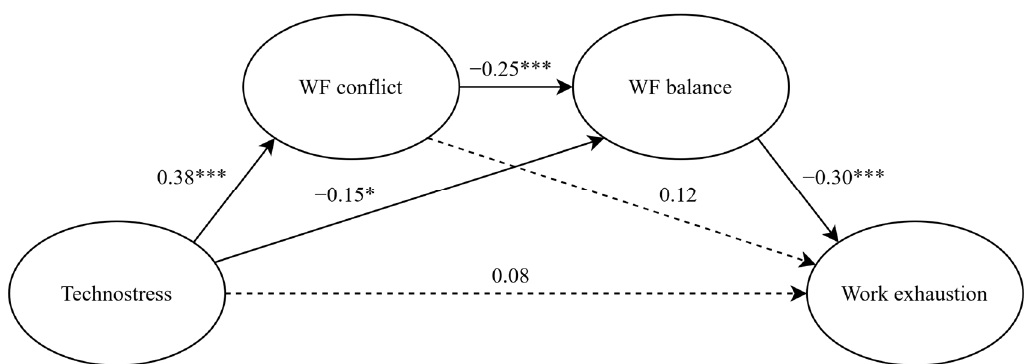
Figure 2. Structural model with standardized direct effects. Note . *** p < 0.001, * p < 0.05. Discontinu- ous lines indicate non-significant parameters. Indicators and control variables are not shown for the sake of clarity.